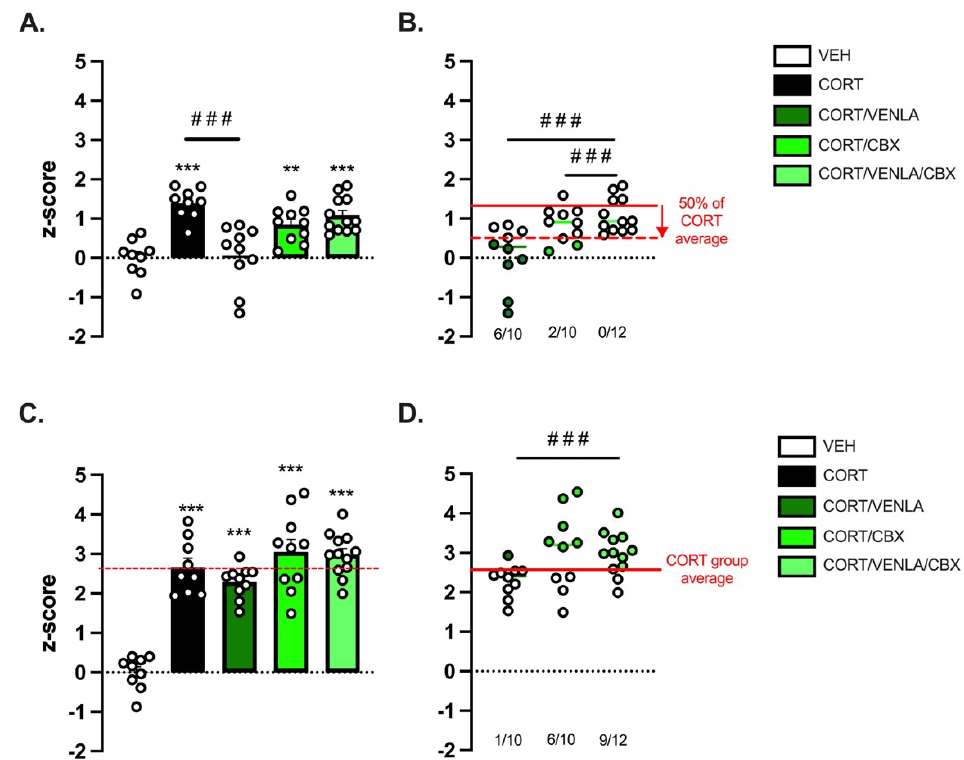
Figure 3. Inactivation of astroglial connexin functions hinders venlafaxine-induced antidepressant- like effects in the corticosterone mouse model of depression. Emotionality z-score was calculated based on a comprehensive battery of behavioral test ran at Week 18 ( A , B ) and Week 23 ( C , D ). A z-score >0 indicates a depressive-like state, whereas a score <0 indicates an antidepressant-like state. On Week 18 ( A ), an individual was considered as “responder to VENLA” when its z-score was <50% of the mean value of the CORT group ( B , green dots). On Week 23 ( C ), after VENLA withdrawal, an individual was considered as “experiencing relapse” if its score was higher than the mean value of the CORT group ( D , green dots). Asterisks indicate statistical significance on raw data: ** p < 0.01 and *** p < 0.005: statistically different from VEH group. Fisher’s exact test: ### p < 0.001: statistically different as indicated.